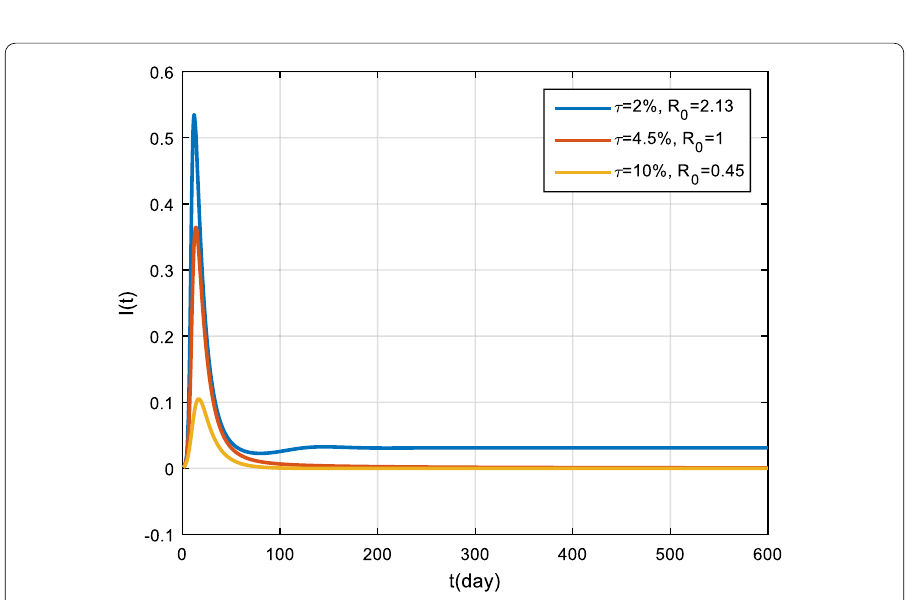
Figure 15 Variation in the number of infected population for different values of τ